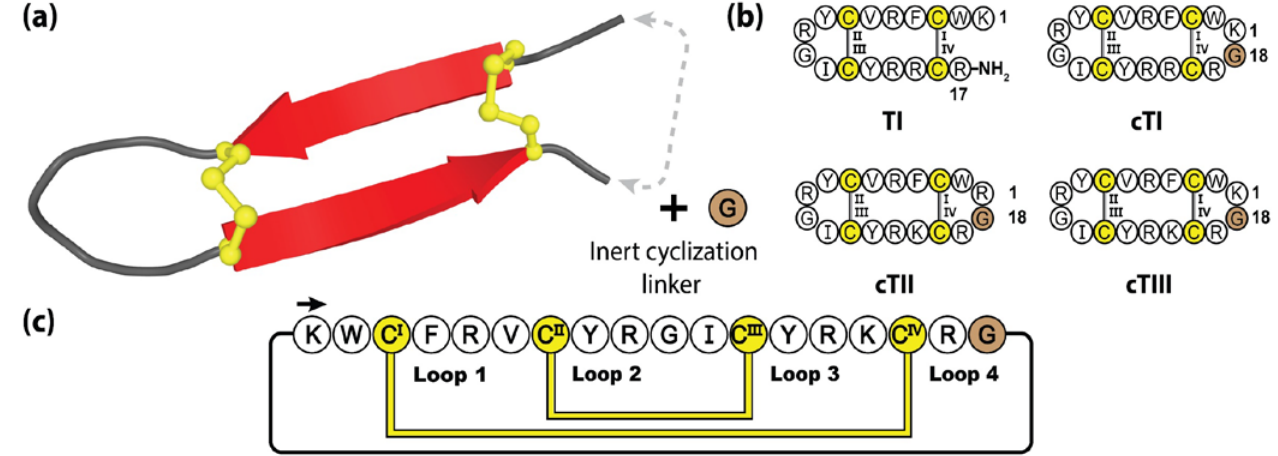
Figure 9. ( a ) Three-dimensional structure of the prototypical tachyplesin TI, with engineered cy- clization linker. ( b ) The native peptide sequence of TI and three engineered cyclic tachyplesin variants. ( c ) Representation of the amino acid sequence, disulfide bond connectivity and loop nomenclature of cTI. Cysteine residues are numbered and highlighted in yellow, with the engineered cyclizing epitope inclusions represented by brown shading.